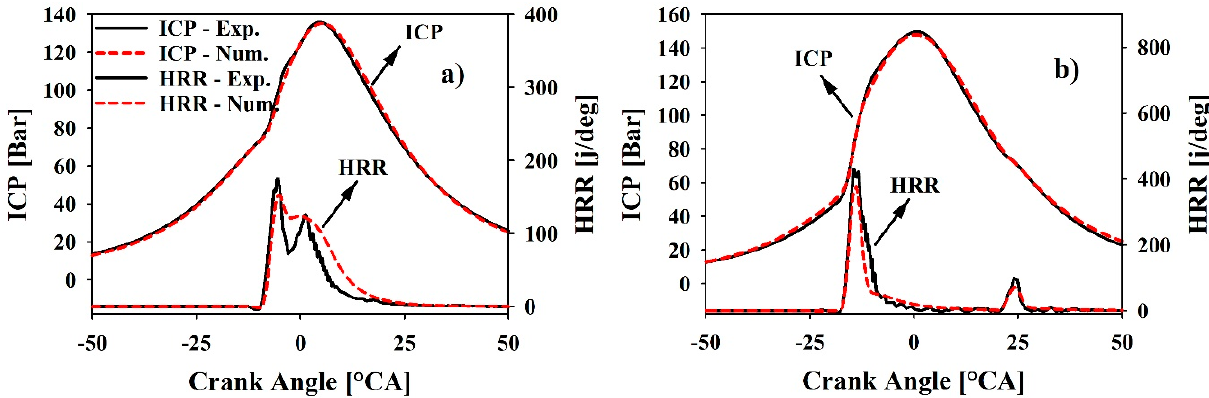
Figure 7. Measured and modelled in-cylinder pressure (ICP) and heat release rate (HRR) for ( a ) the single injection (Baseline) and ( b ) post injection case (Case 3) .